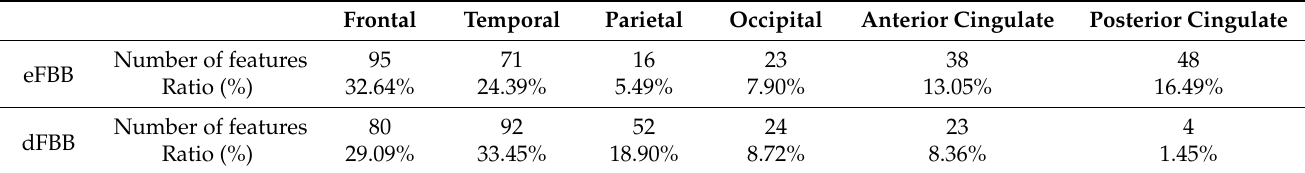
Table 4. Simple and relative frequency distribution for feature selection in multiple training